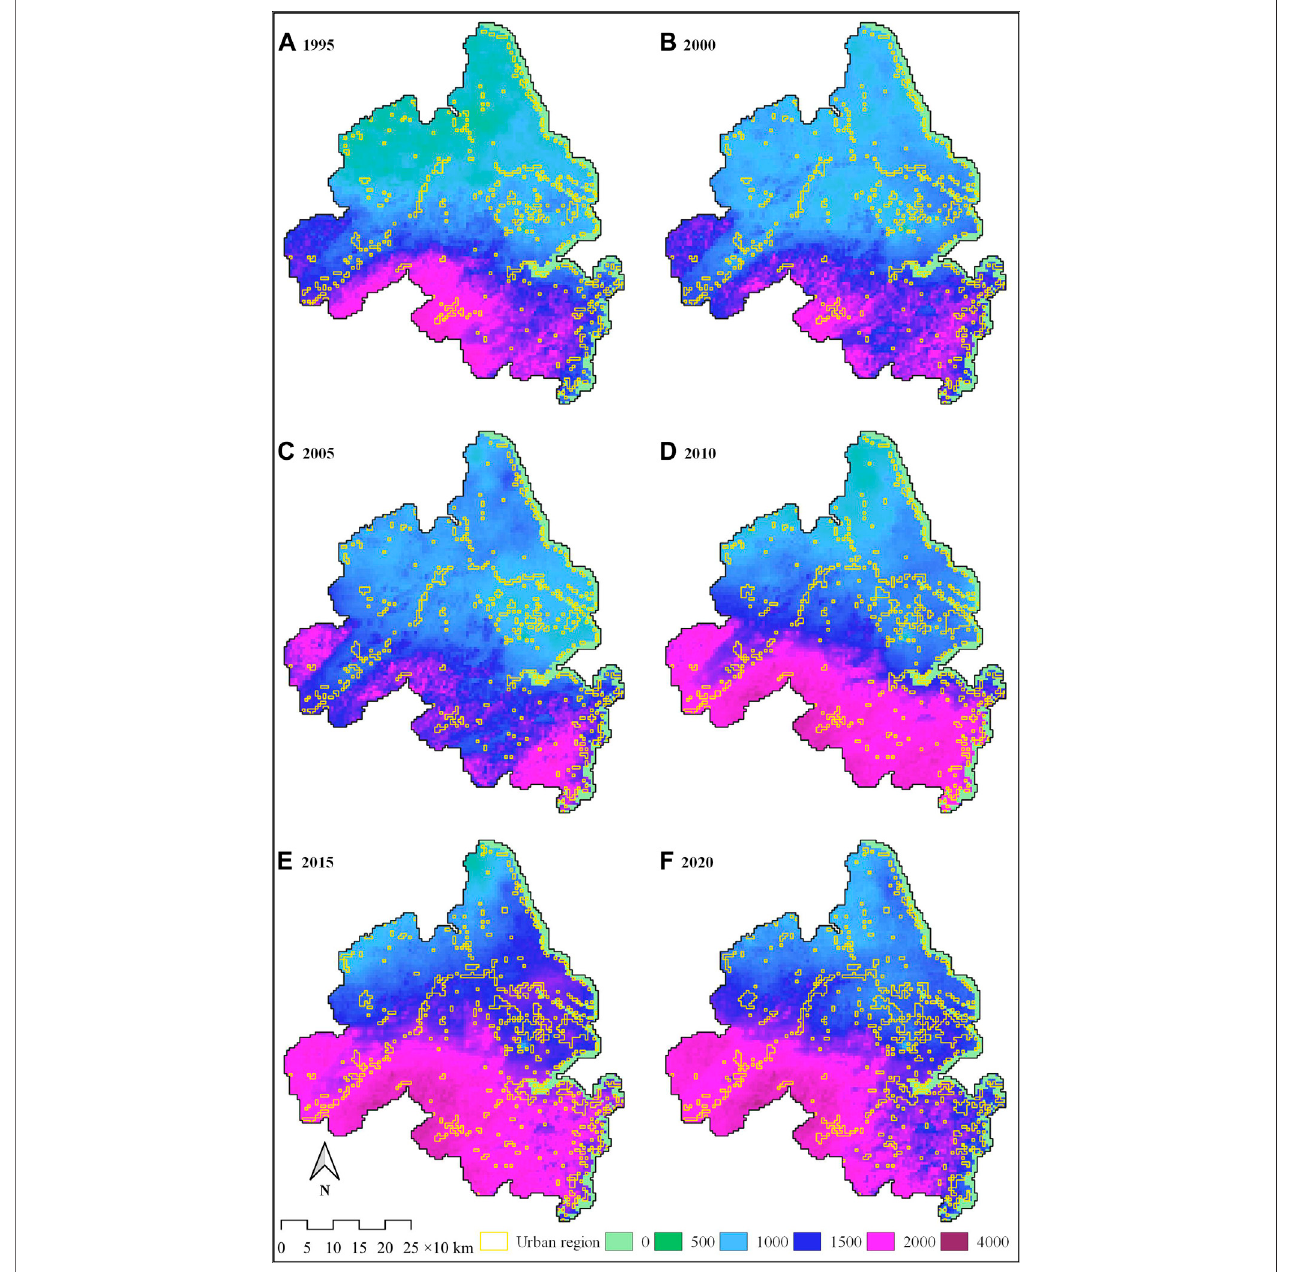
FIGURE 10 | The distribution of annual TP in the YDM at quinquennial intervals from 1995 to 2020.